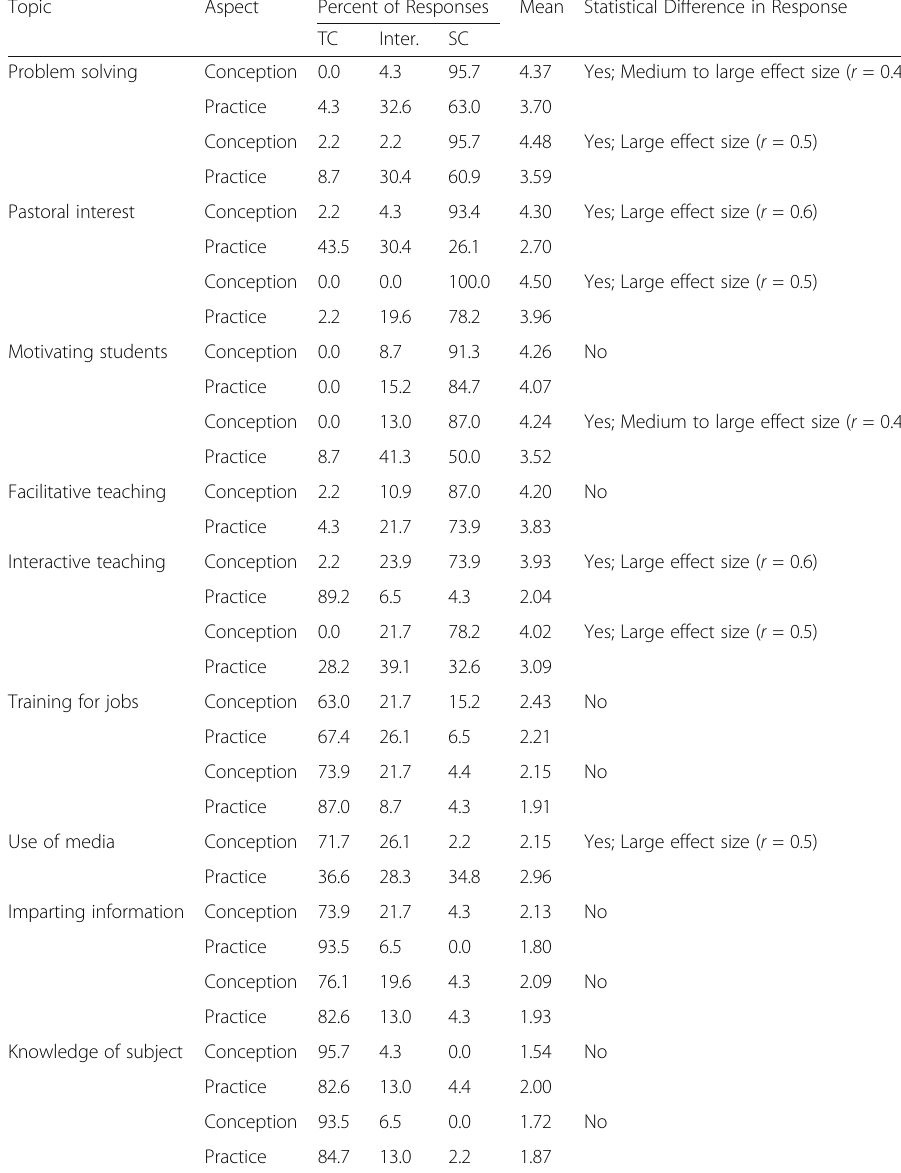
Table 4 Differences between conceptions of teaching and enacted practice Topic